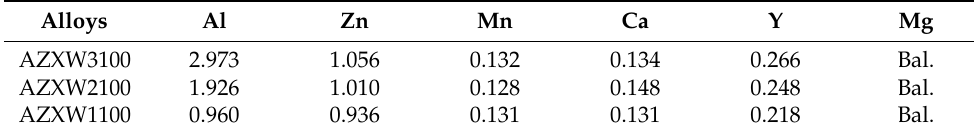
Table 1. Chemical composition (in wt.%) of the studied alloys.